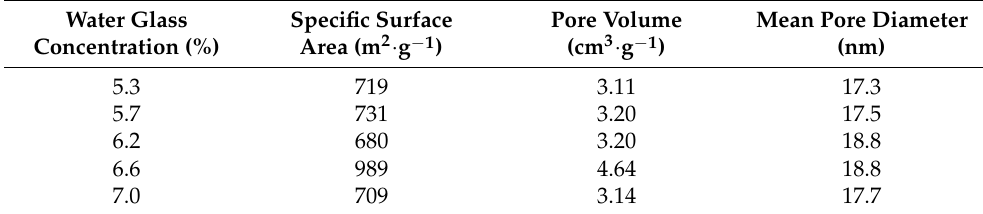
Table 2. Physical properties of silica aerogel powders synthesized from different water glass